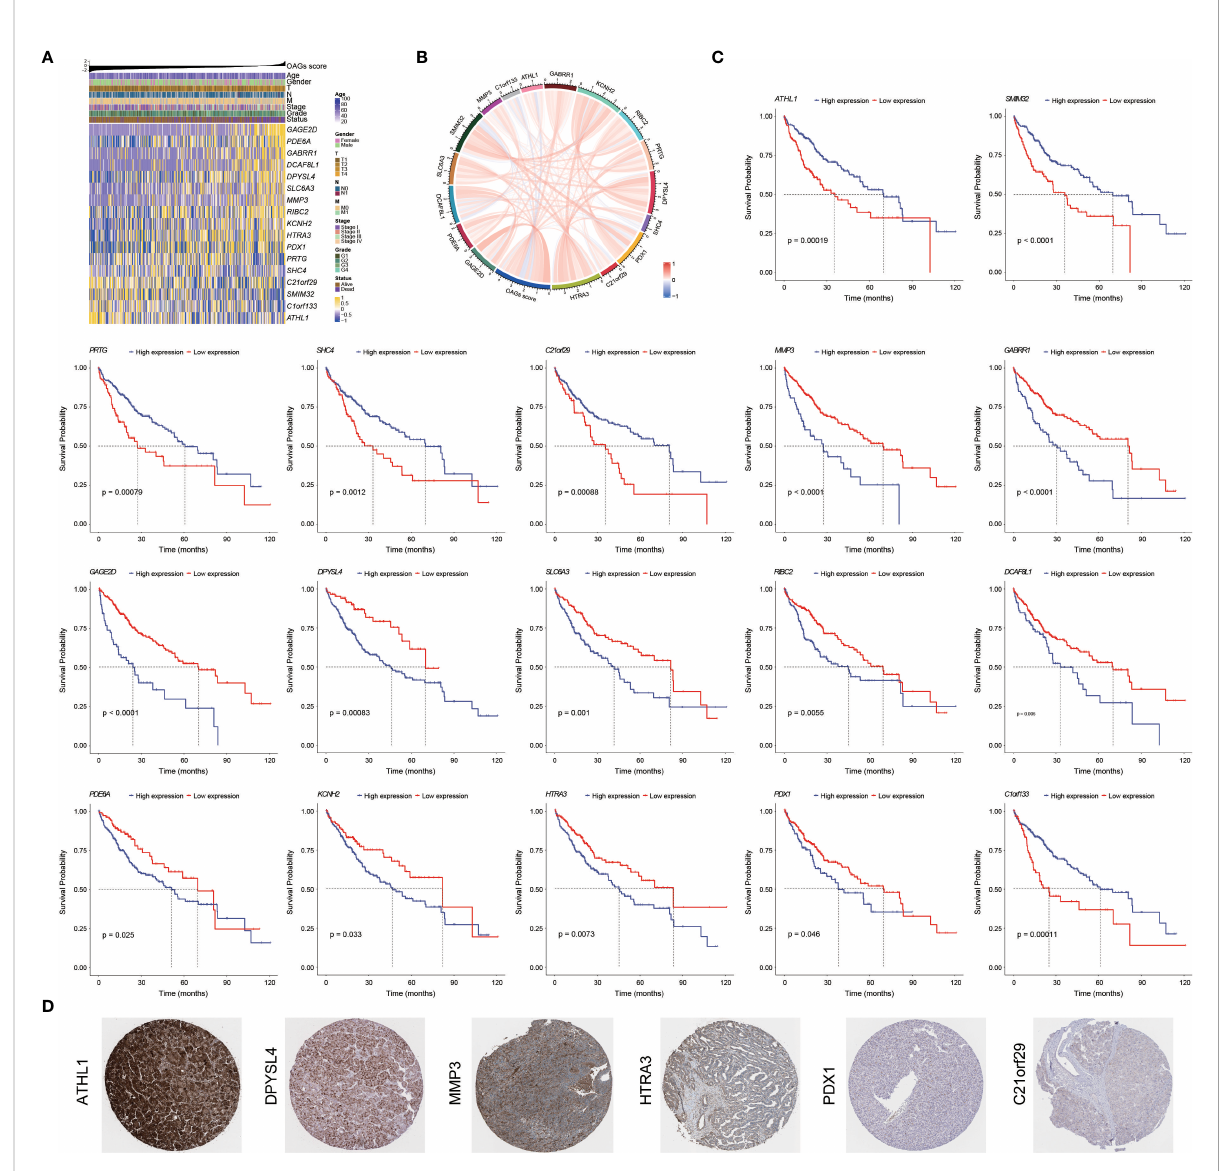
FIGURE 4 Prognostic signi fi cance and contribution of overweight-associated genes (OAGs) involved in the signature. (A) The heatmap for OAG expression pro fi ling. (B) The correlation between OAG expression and OAG score. (C) Kaplan – Meier curve analysis based on the expression of single OAG. (D) The immunohistochemistry staining of OAG protein expression in TCGA-HCC